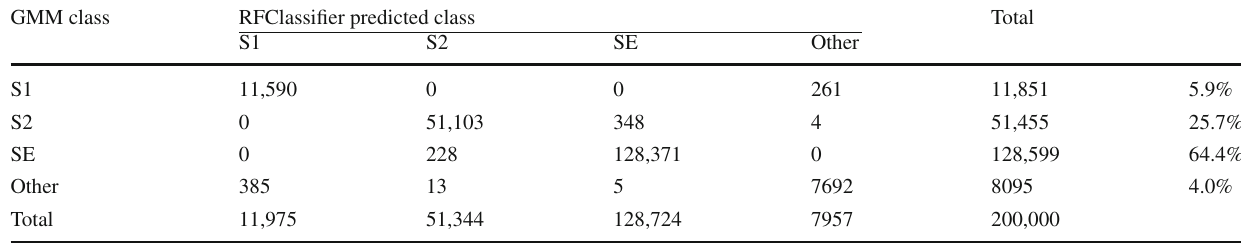
Table 2 Confusion matrix of the RFClassifier results over the test dataset, using the GMM results as the target labels